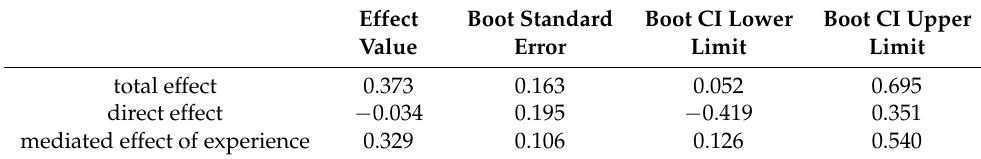
Table 2. Decomposition of the total effect, direct effect, and mediated